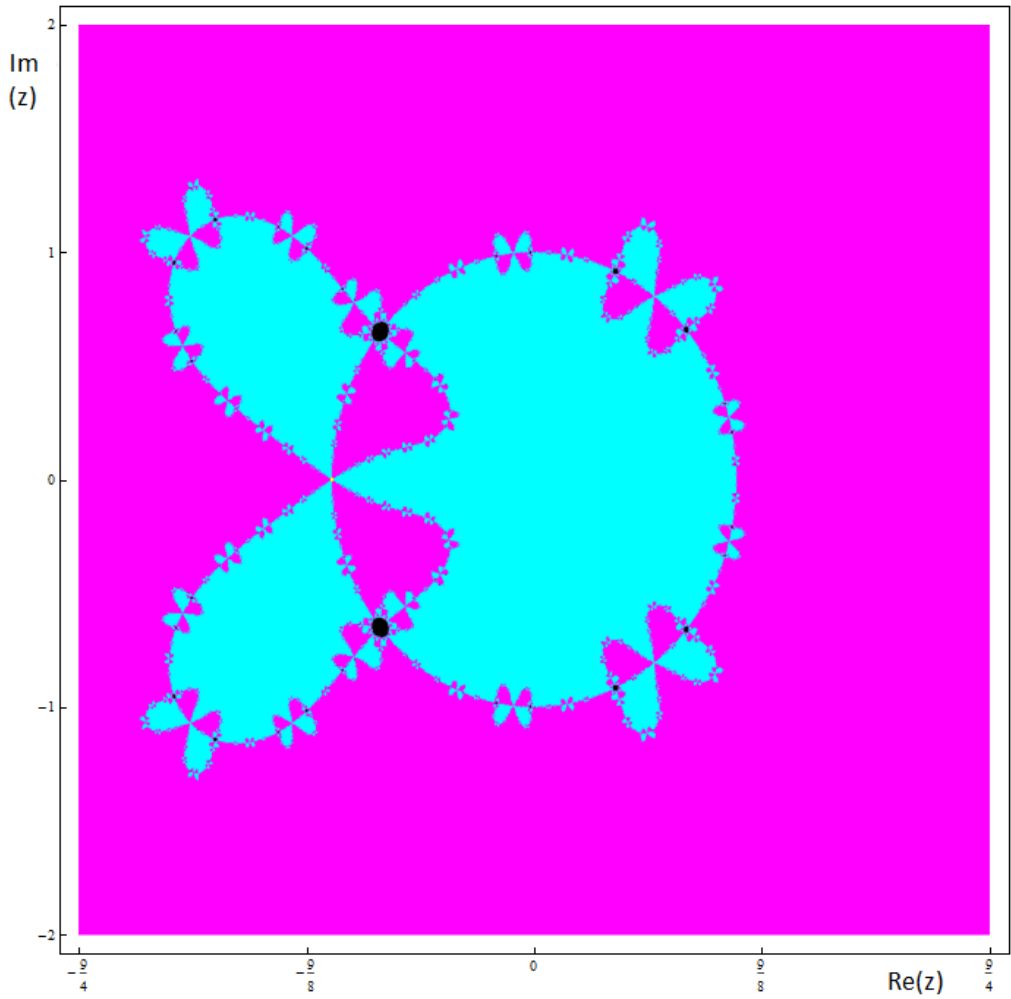
Figure 10. Basins of attraction associated to the member of the family a 0 = 5 and a 1 = 0.1375. The black zones in this case correspond with zones of convergence to a